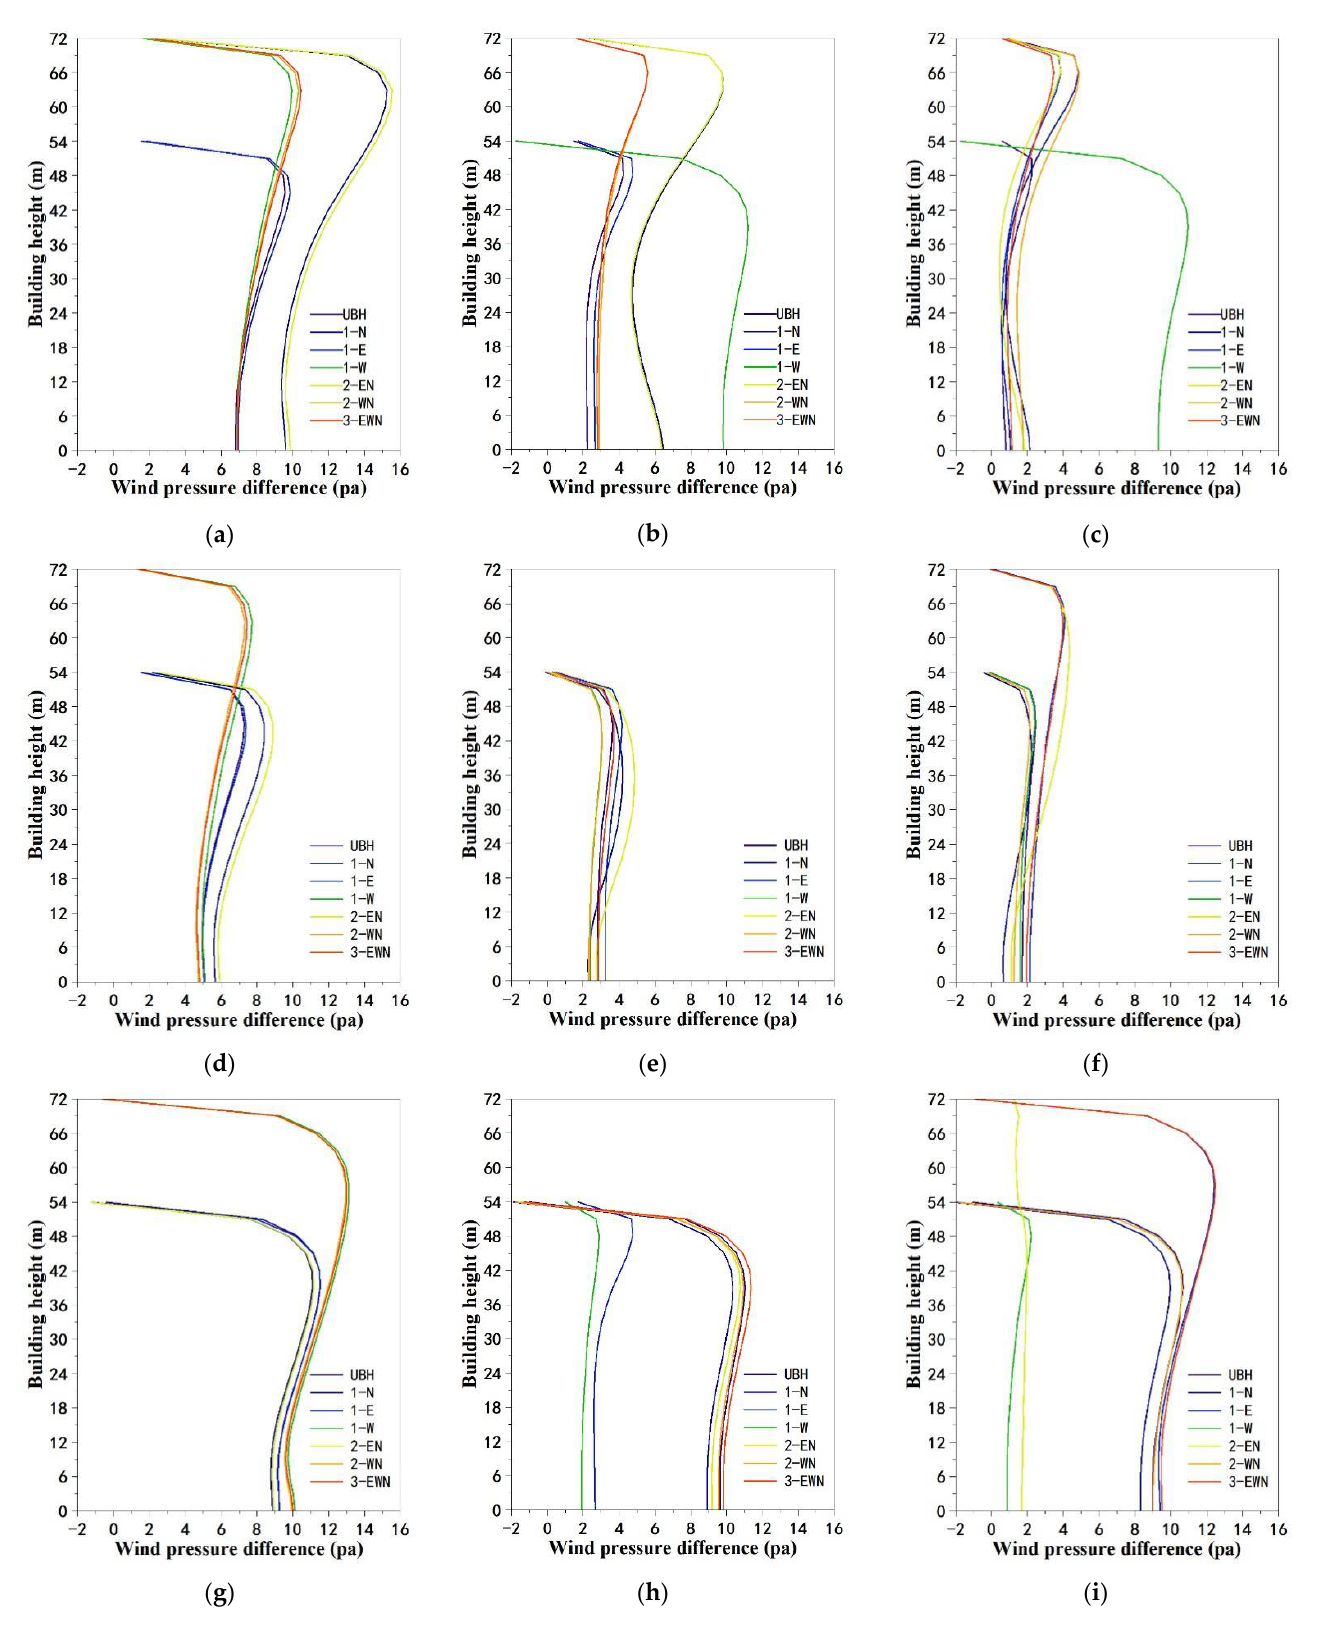
Figure A11. Wind pressure difference of individual buildings under seven operating conditions; ( a ) building #1, ( b ) building #2, ( c ) building #3, ( d ) building #4, ( e ) building #5, ( f ) building #6, ( g ) build- ing #7, ( h ) building #8, and ( i ) building #9.